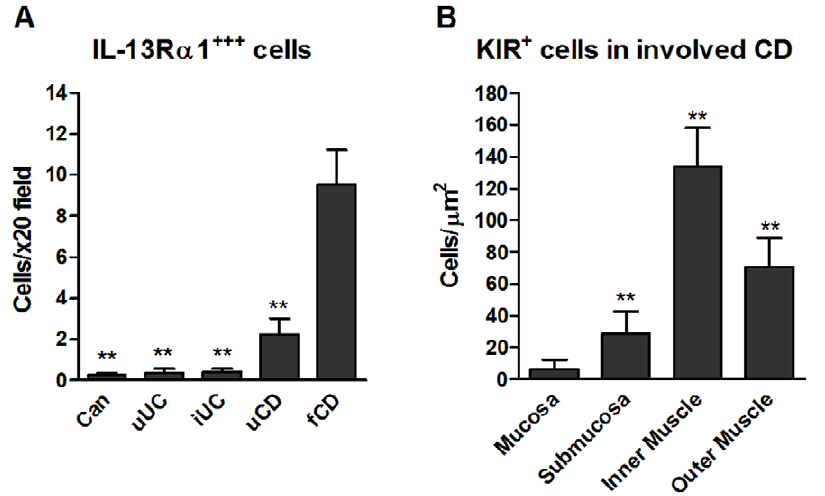
Figure 6. IL-13R a 1 and KIR expressing-cells are increased in fibrotic CD, particularly in the muscle, by image analysis of immunostained frozen tissue sections. (A) Total number of mononuclear cells/field expressing very high levels of R a 1 and no co-expression of R a 2 in muscle tissue (**p , 0.01 to fCD), n=8 for all groups except n=3 for uUC. (B) Distribution of cells expressing very high levels of KIR in involved CD tissue. Data are the mean + SD of from 3 patients (20 images/patient), (*p , 0.01 all comparisons).